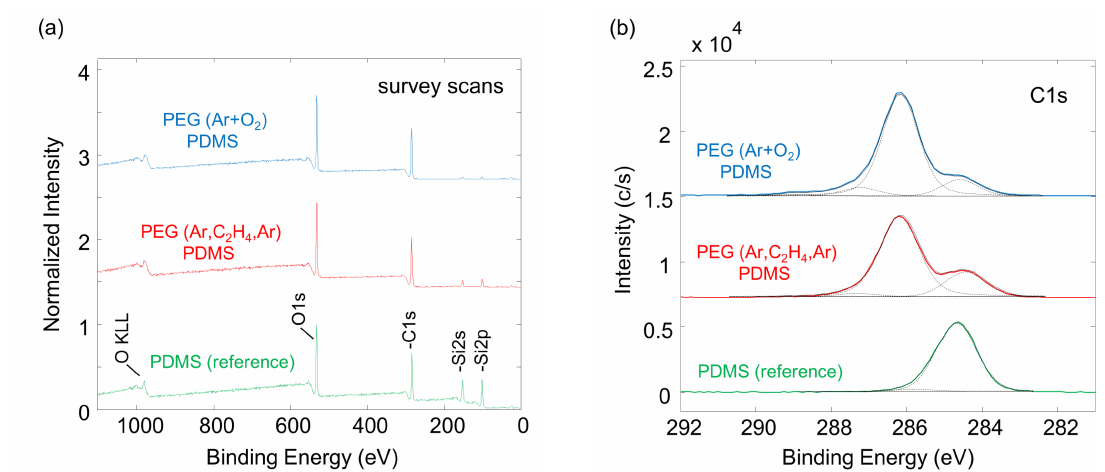
Figure 8. Comparison of XPS spectra of PDMS and plasma-processed PEG. The spectra are offset in the y -direction for better visualization. ( a ) Survey scans with a normalized signal intensity of one for the strongest peak. ( b ) Carbon C1s high-resolution scans (full lines) and composite